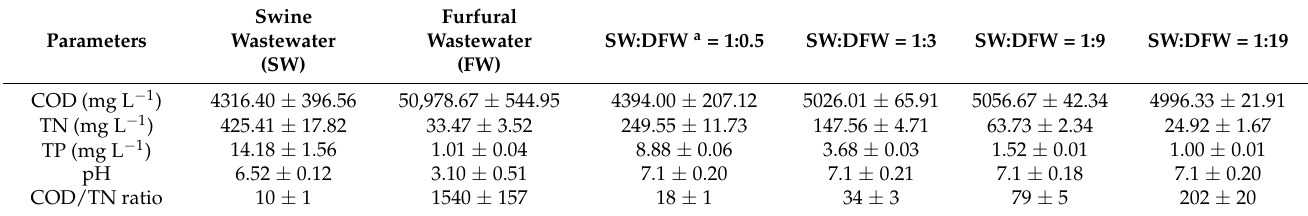
Table 1. Physicochemical characteristics of swine wastewater (SW), furfural wastewater (FW), and the mixed wastewater at different ratios of SW to DFW. Data are shown as mean ± SD, n =